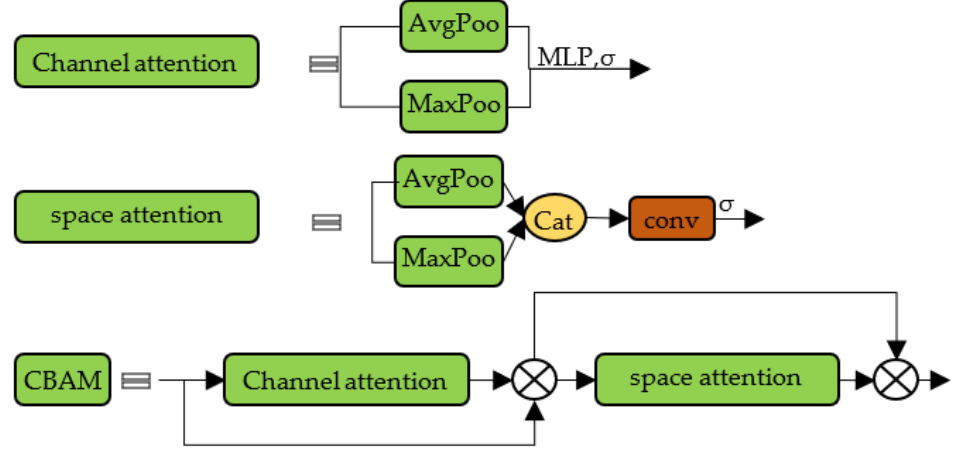
Figure 2. CBAM network structure.